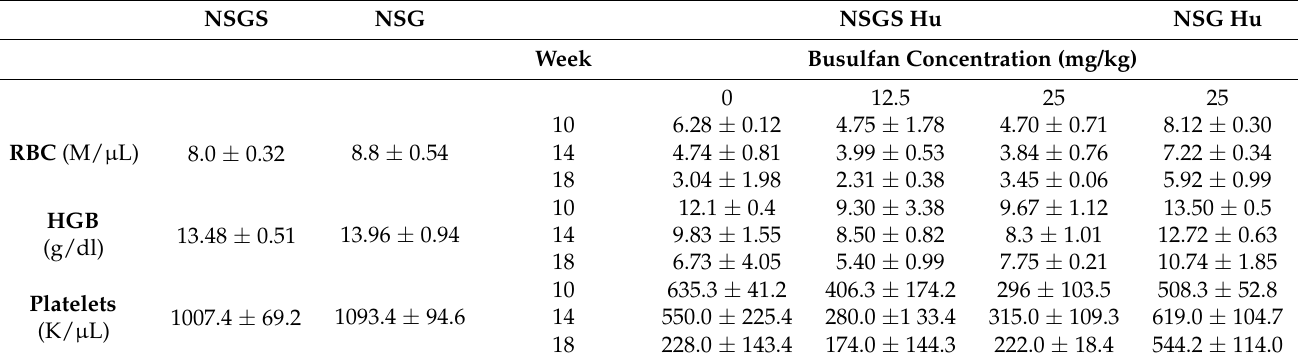
Table 1. NSGS mice engrafted with human umbilical cord blood develop pancytopenia. NSGS NSG NSGS Hu NSG